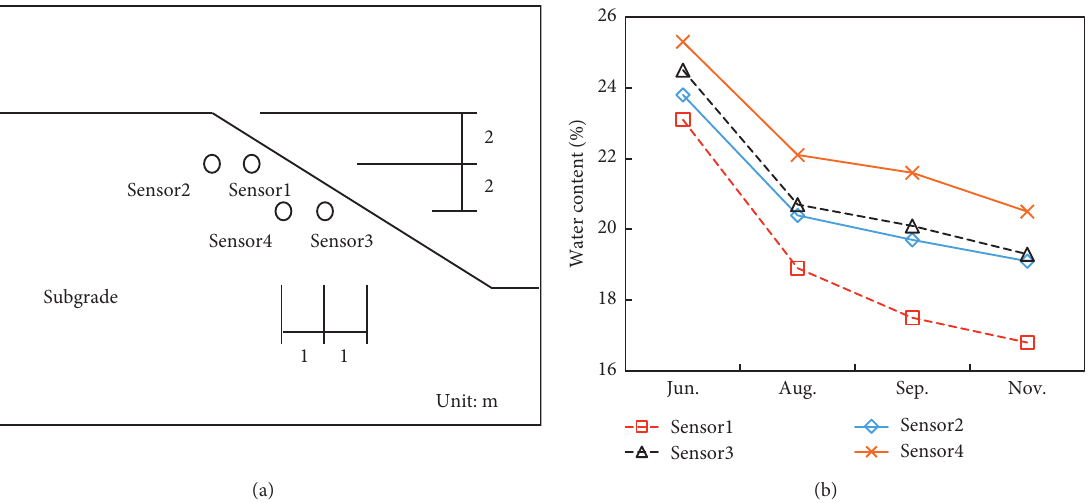
Figure 6: Field (a) sensor layout plot and (b) moisture-time relationship of